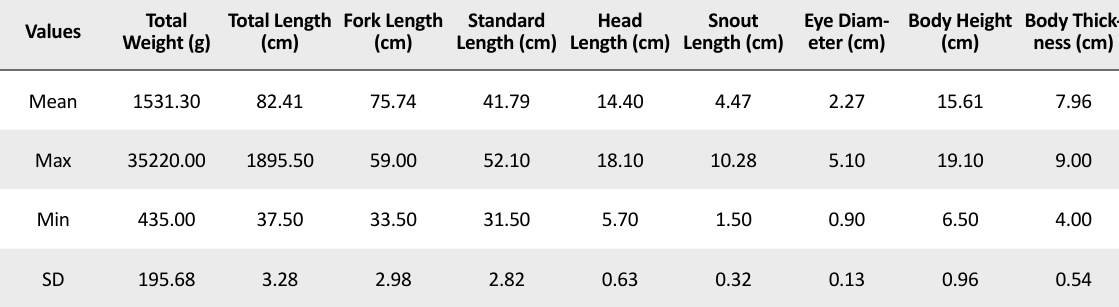
Table 1. Morphometric characteristics of Rutilus kutum from the three studied areas of the South Caspian